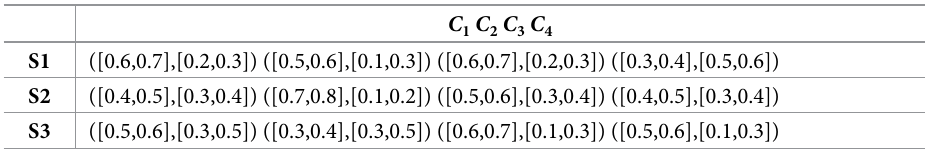
Table 2. The attribute weight given by the experts C 1 C 2 C 3 C 4